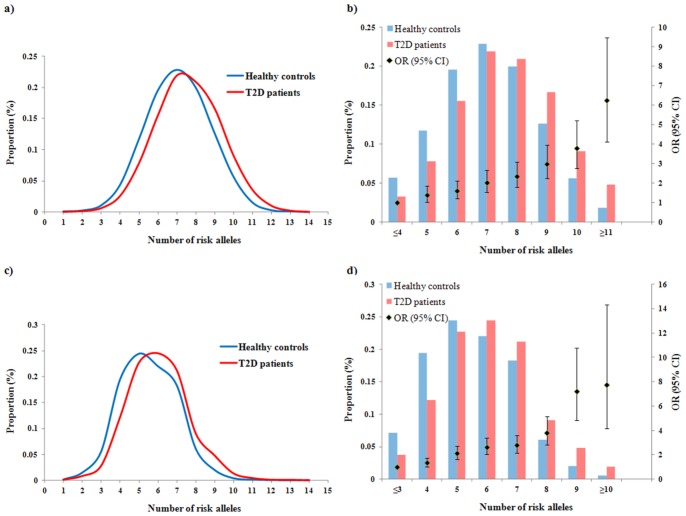
Distributions and effects of unweighted (a–b) and weighted (c–d) CGSs on T2D risk.